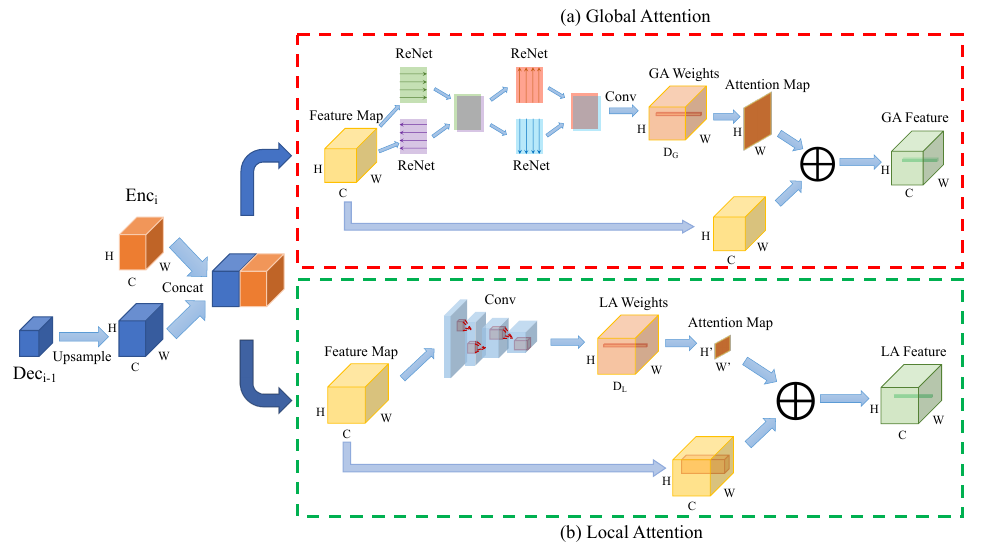
Figure 3. The architecture of our U-SalNet model. ( a ) Global Attention and ( b ) Local Attention corresponds to (cid:78) and (cid:78) from Figure 2b, respectively. GA and LA stand for Global Attention and Local Attention. Conv means the convolution operation. (cid:76) stands for weighted summation over the feature